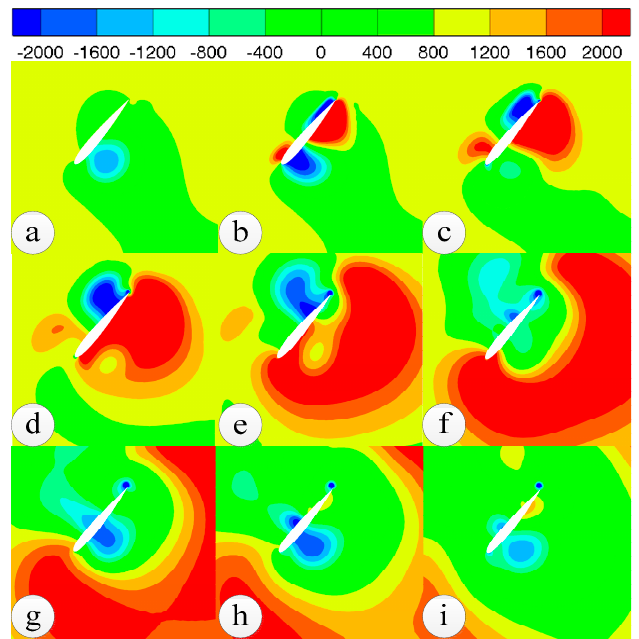
Figure 21. Evolution of the instantaneous pressure contours at ( a ) t / T = 0.324, ( b ) t / T = 0.326, ( c ) t / T = 0.328, ( d ) t / T = 0.33, ( e ) t / T = 0.332, ( f ) t / T = 0.334, ( g ) t / T = 0.336, ( h ) t / T = 0.338, ( i ) t / T = 0.34 for y 0 = 0.2, f ∗ = 0.68, k ∗ = 0.09, θ c = 50 ◦ .